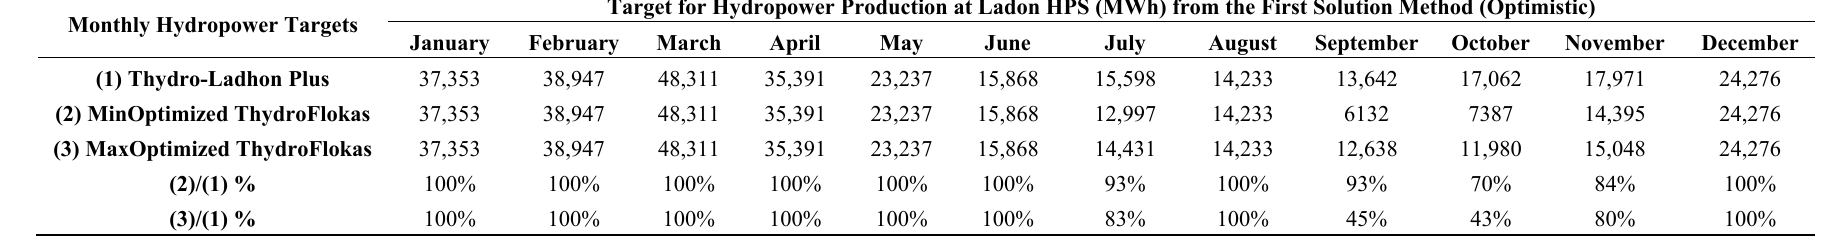
Table 19. Maximum allowable (THydro-LadhonPlus) and minimum (MinOptimized THydroFlokas) and maximum (MaxOptimized THydroFlokas) optimized monthly targets of hydropower production at Flokas HPS (MWh) and their ratios in (%) for the first solution method